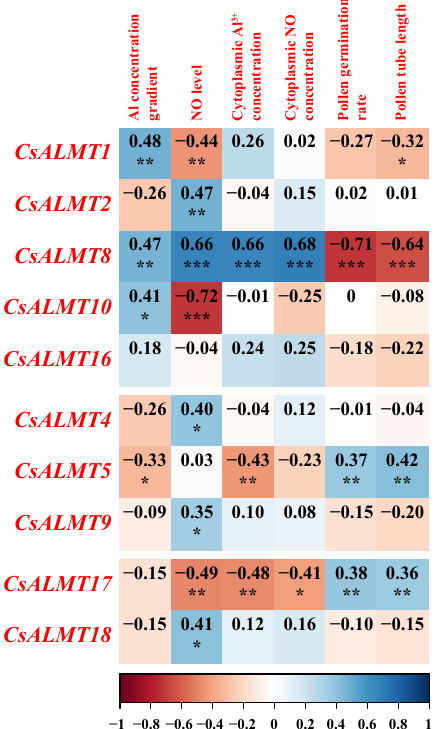
Figure 5. The modified (the data under 5 mM Al 3+ treatment were removed) Pearson correlation coefficients between Al 3+ concentration gradient and NO level in the culture medium, cytoplasmic Al 3+ and NO concentration, pollen germination rates, pollen tube lengths and CsALMTs expression levels. Significant differences are reported as * (0.01 < p < 0.05), ** (0.001 < p < 0.01) and *** ( p < 0.001), as determined by the Duncan test.